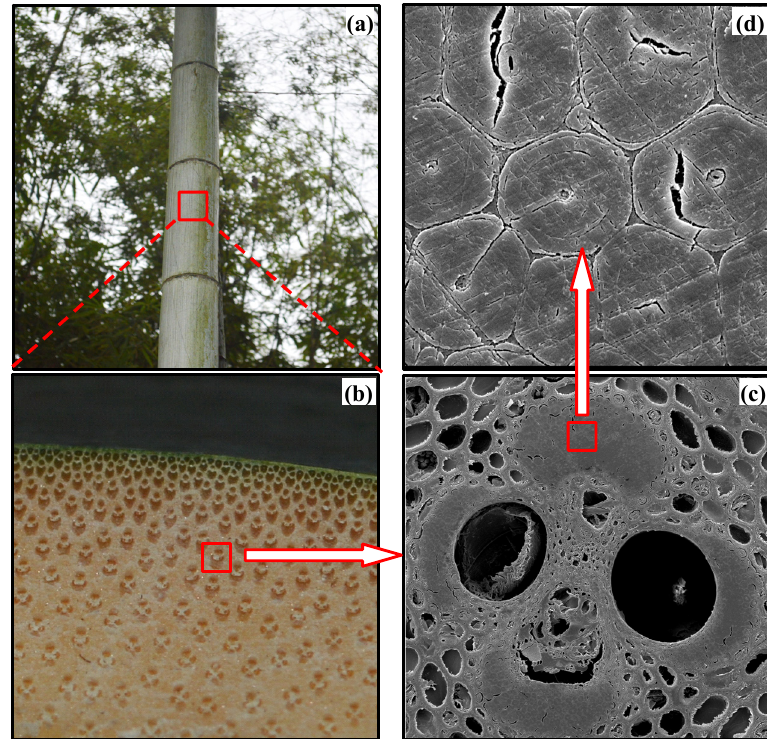
Figure 2. Hierarchical structure of bamboo fiber across different length scales. ( a ) Bamboo culm; ( b ) Cross section of the culm; ( c ) Vascular bundle; ( d ) Elementary fibers.